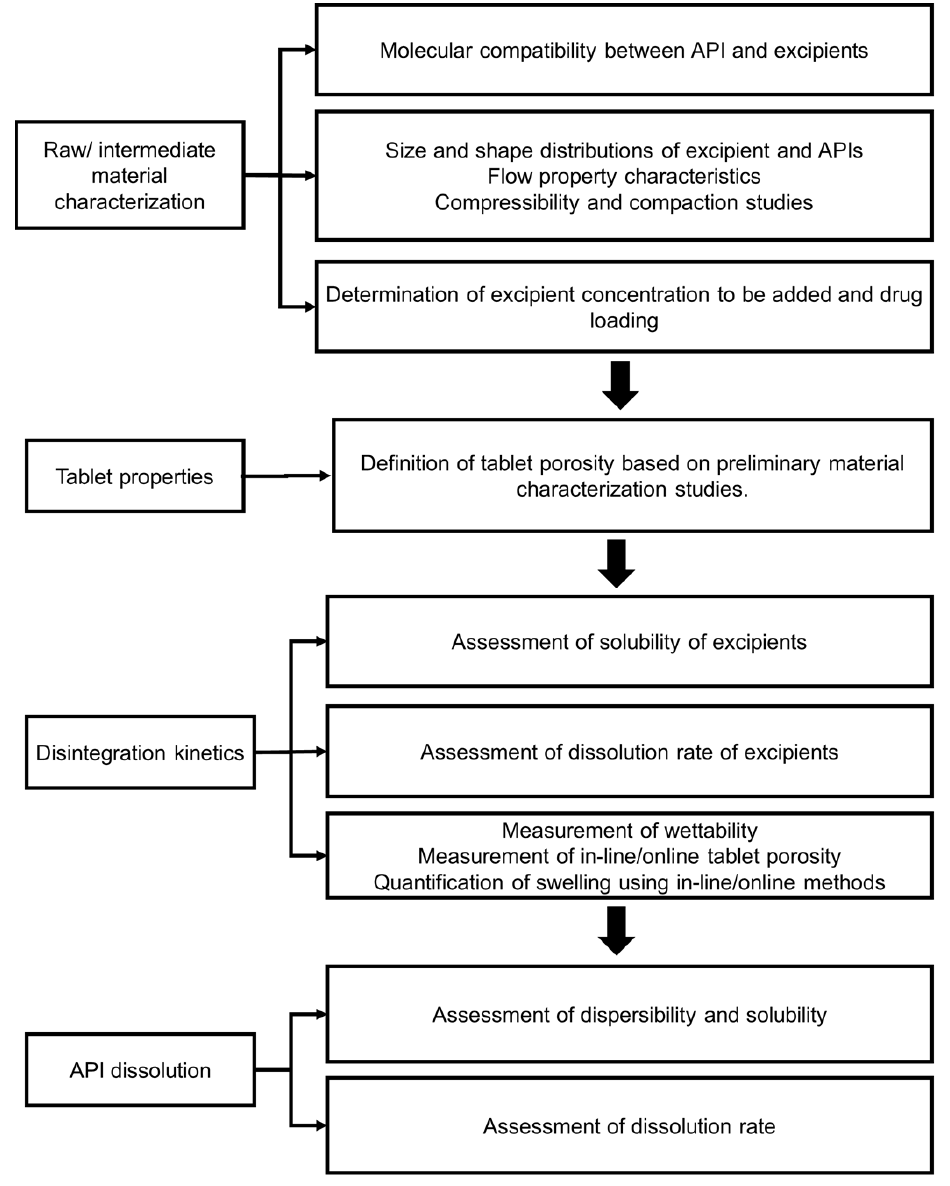
Figure 5. Stages for assessment of the interplay between formulation and tablet microstructure on the disintegration until complete dissolution of the API from immediate-release tablets.